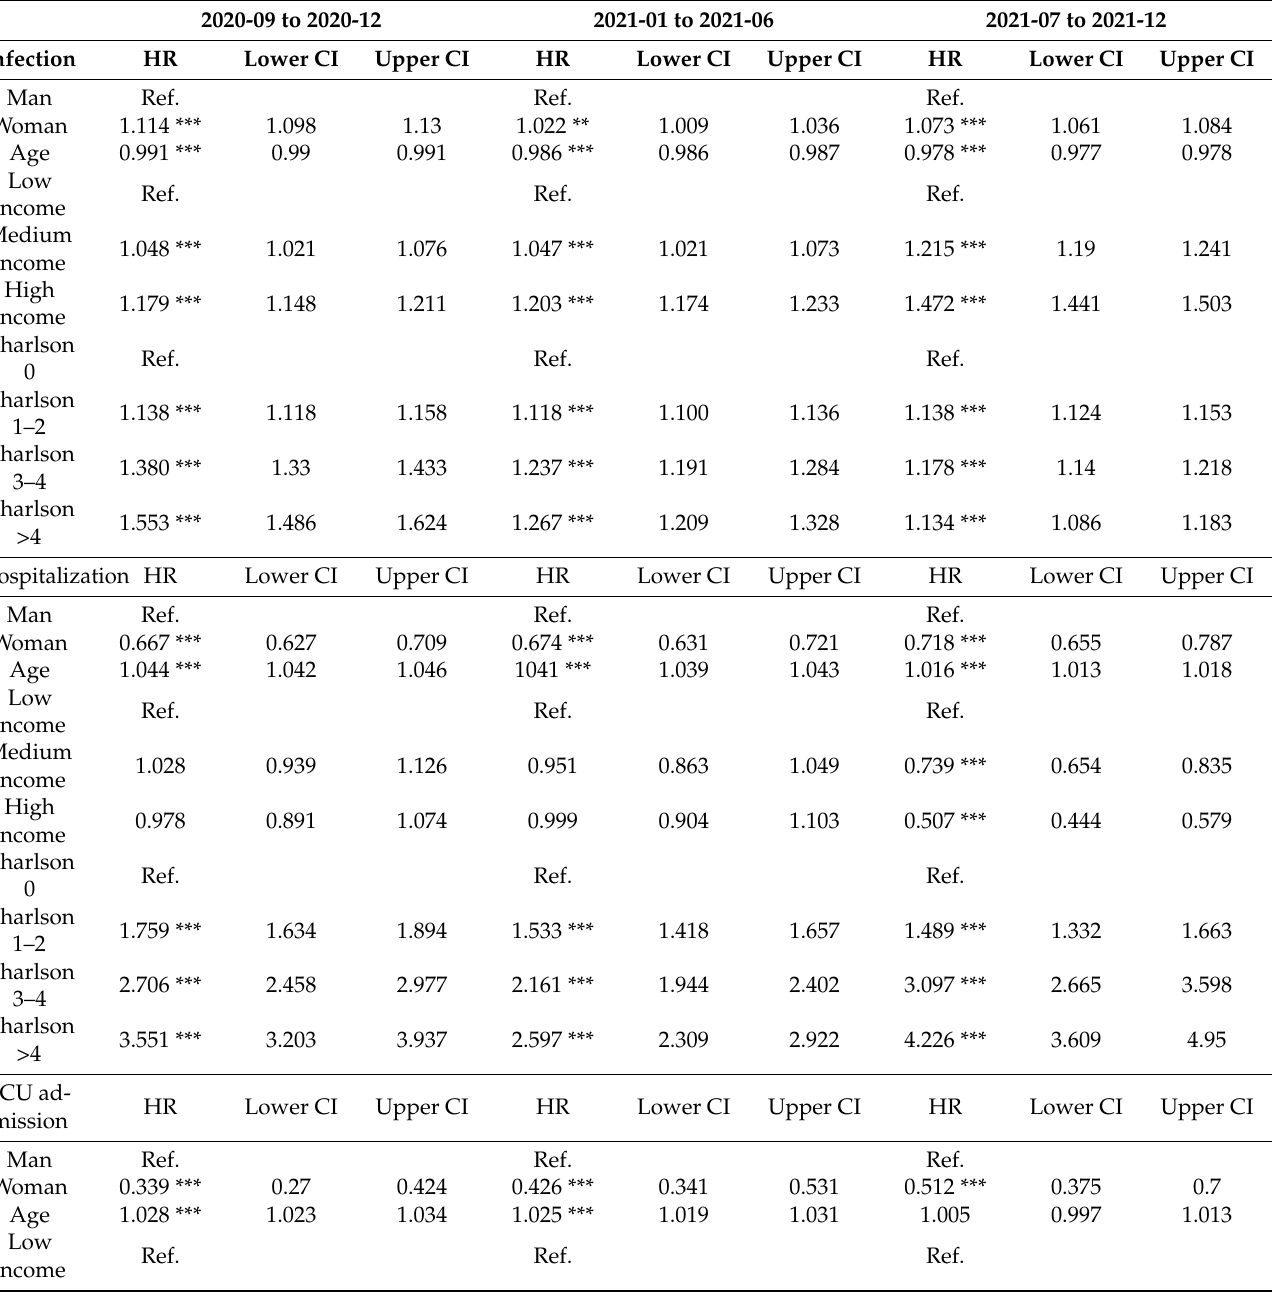
Table 3. Change in the adjusted risk of cases, hospitalizations, and ICU admissions in the three periods measured by hazard ratios (Cox